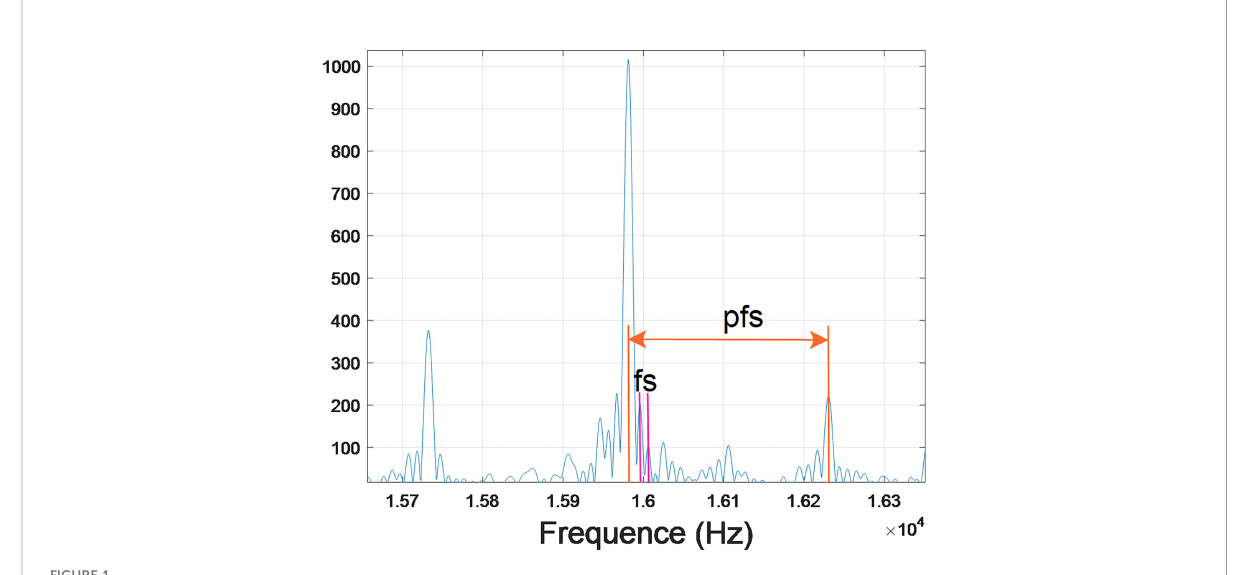
FIGURE 1 AUV propulsion motor PWM frequency and harmonic